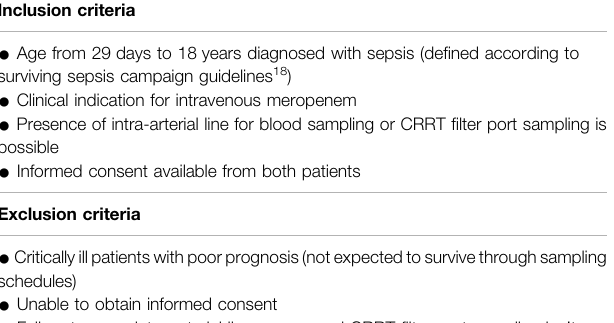
TABLE 1 | Inclusion and exclusion criteria.